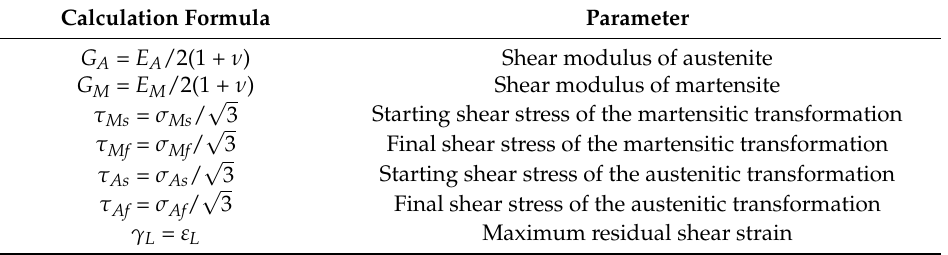
Table 1. The formulas for the material parameters in the shear stress-strain